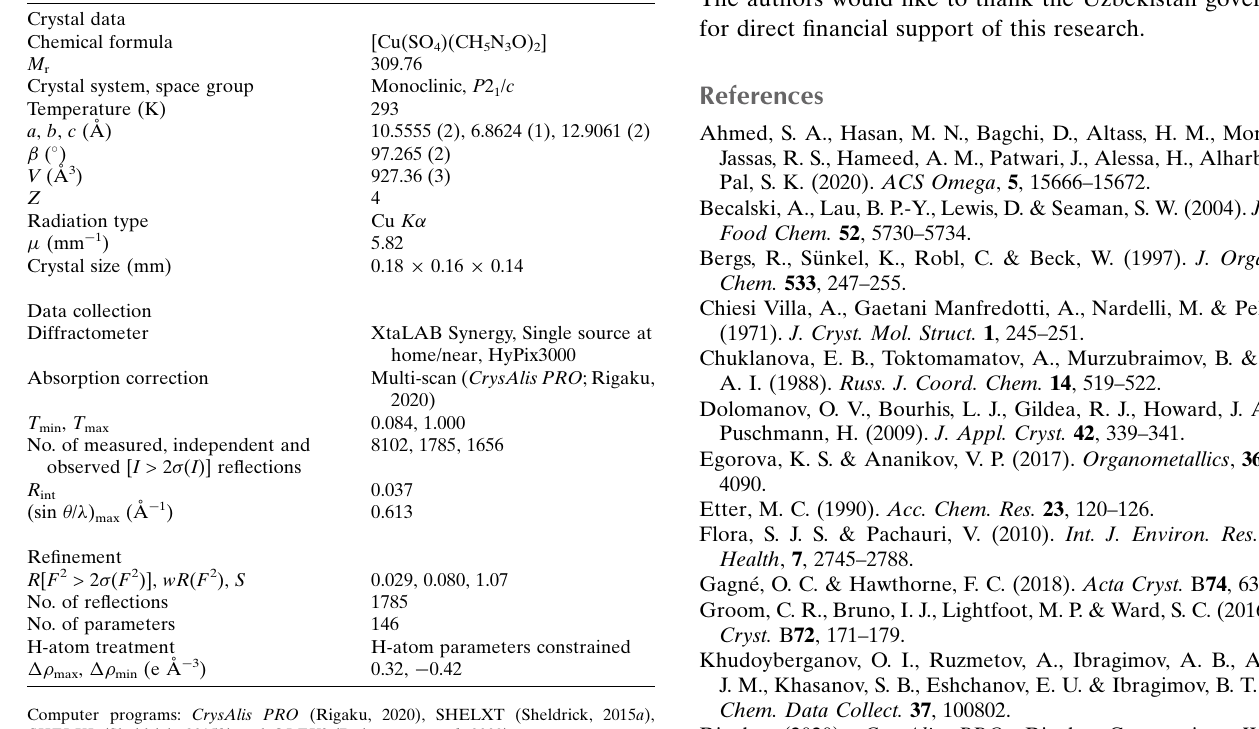
Table 3 Experimental